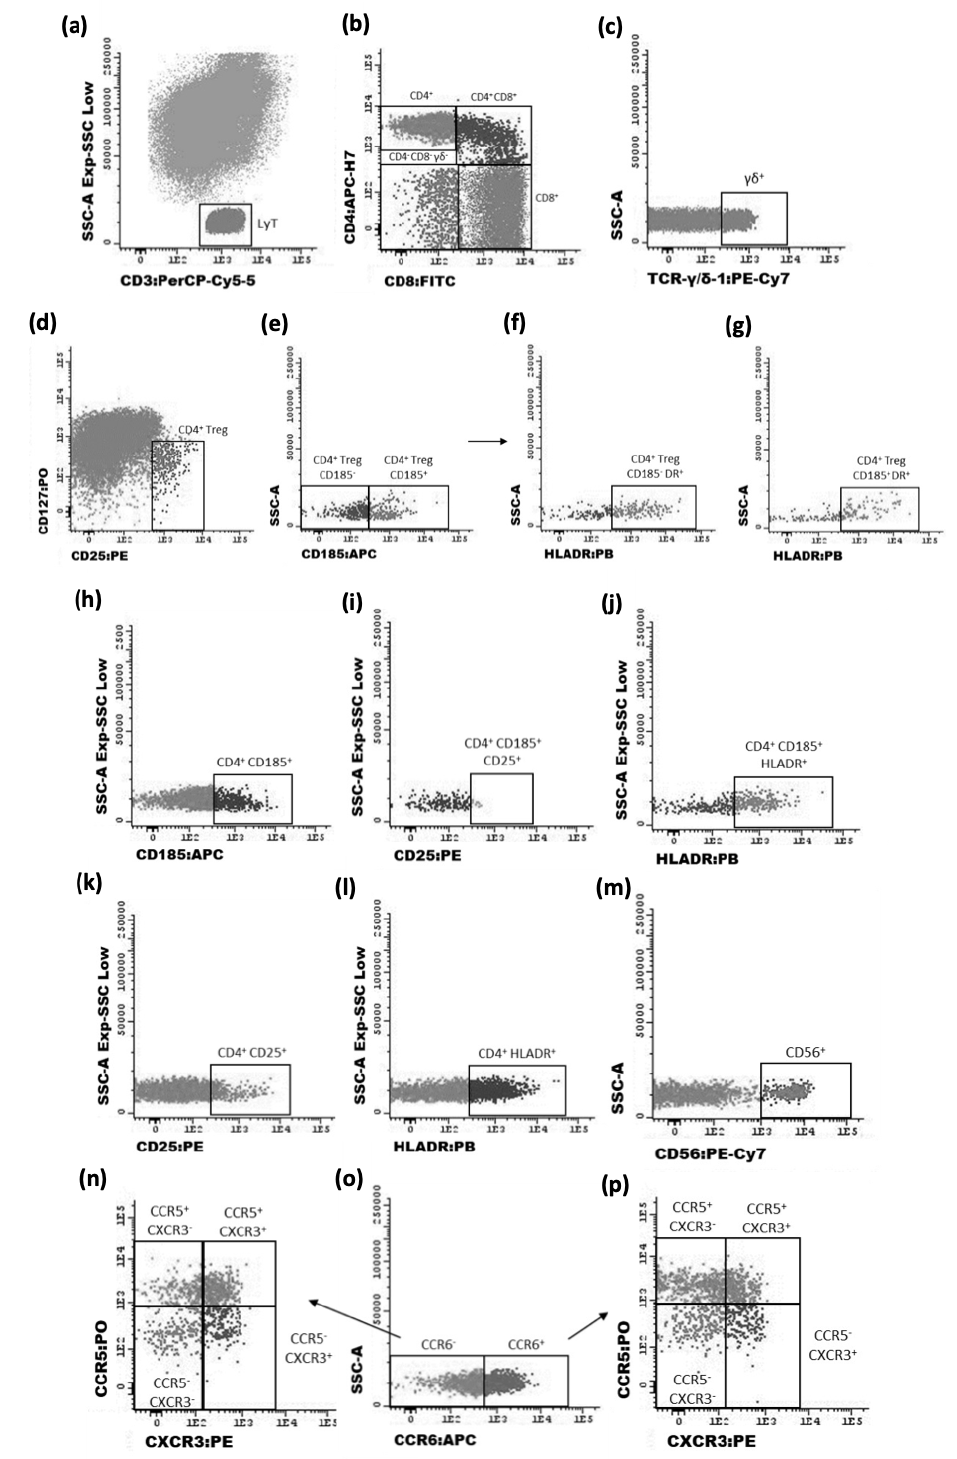
Figure 2. Representative dot plot histograms showing the gating strategy used for the identification of CD4 T-cell subpopulations. T lymphocytes were identified by the expression of CD3 ( a ); among them, five major subpopulations were found (CD4 + , CD8 + , CD4 + CD8 + , CD4 − CD8 − and γδ + T cells) ( b , c ). Treg cells were identified as CD25 bright CD127 − /low ( d ) and the subpopulation follicular-like Tregs by the expression of CD185 ( e ), as well as its activation profile by the expression of HLA-DR + ( f , g ). The follicular-like T-cell subsets were evaluated by CD185 expression and its activation profile (CD25 + or HLA-DR + ) ( h – j ). The activated (CD25 + or HLA-DR + ) non-follicular non-Treg CD4 T cells were also measured ( k , l ). The percentage of CD4 T cells with an NK-like phenotype (CD56 + ) was